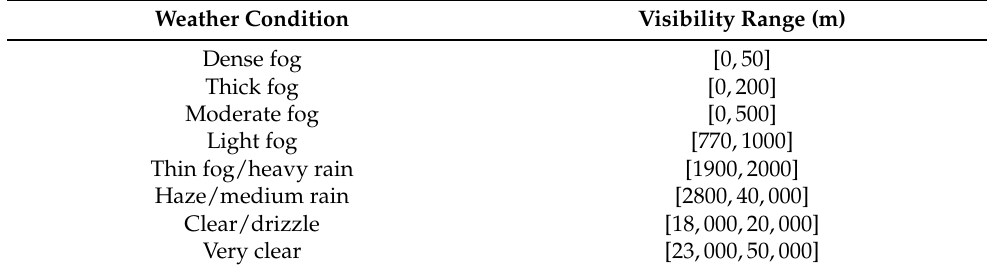
Table 2. Weather conditions and their visibility range values